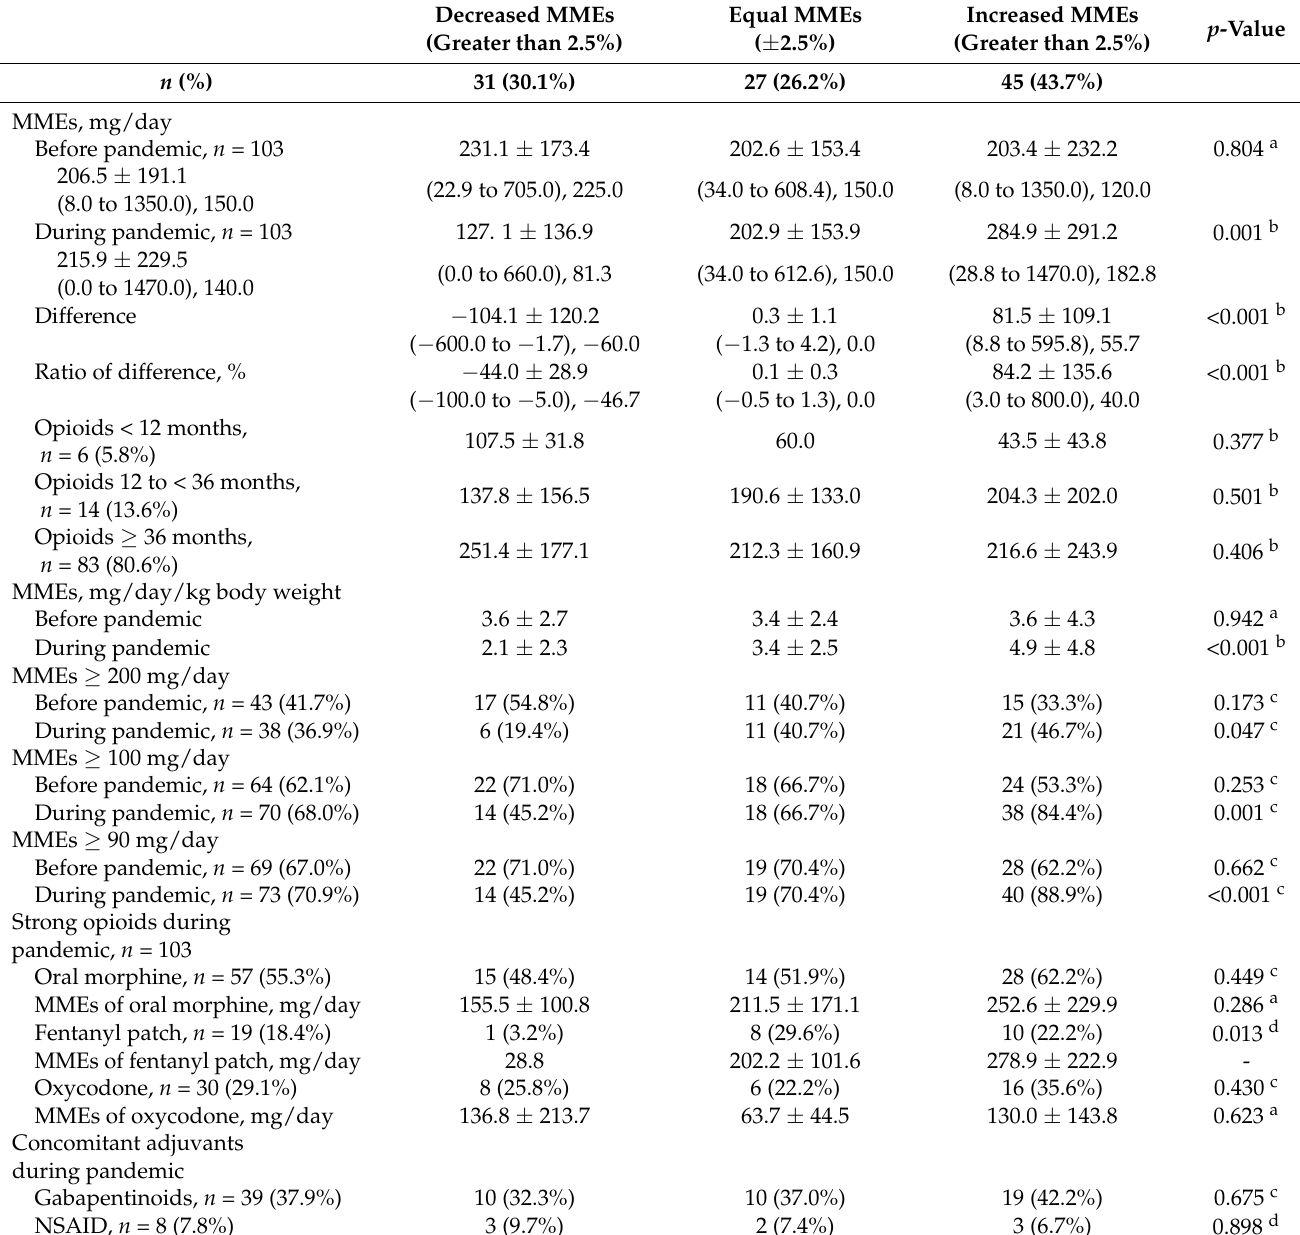
Table 2. Opioid prescriptions, daily opioid dose, and nonopioid medications ( n =